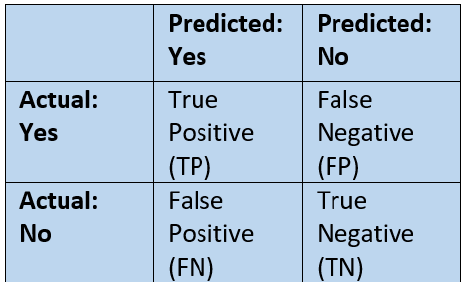
Figure 5. A simple confusion